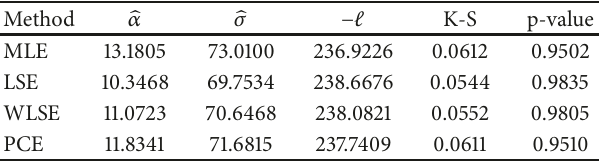
Table 9: The goodness of fit statistics for parameter estimatedunder various methods for Tcs.